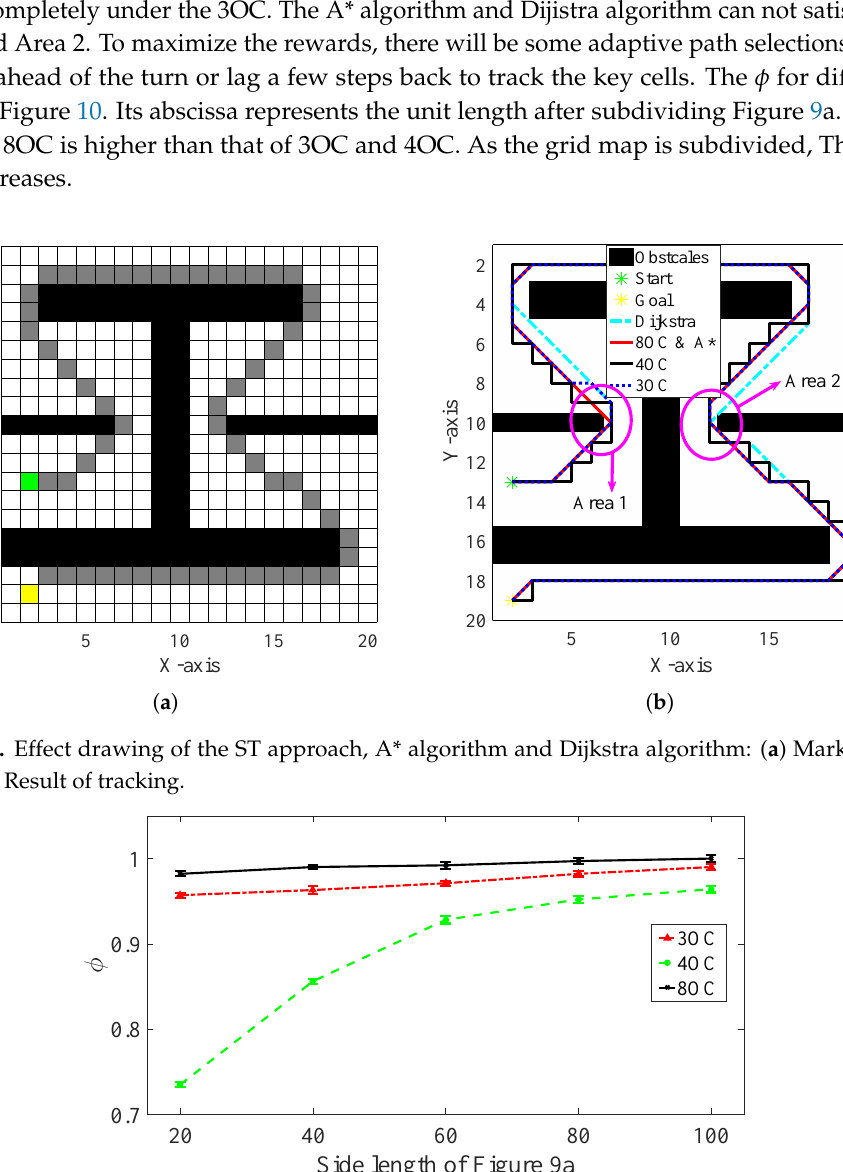
Figure 10. Search efficiency under different